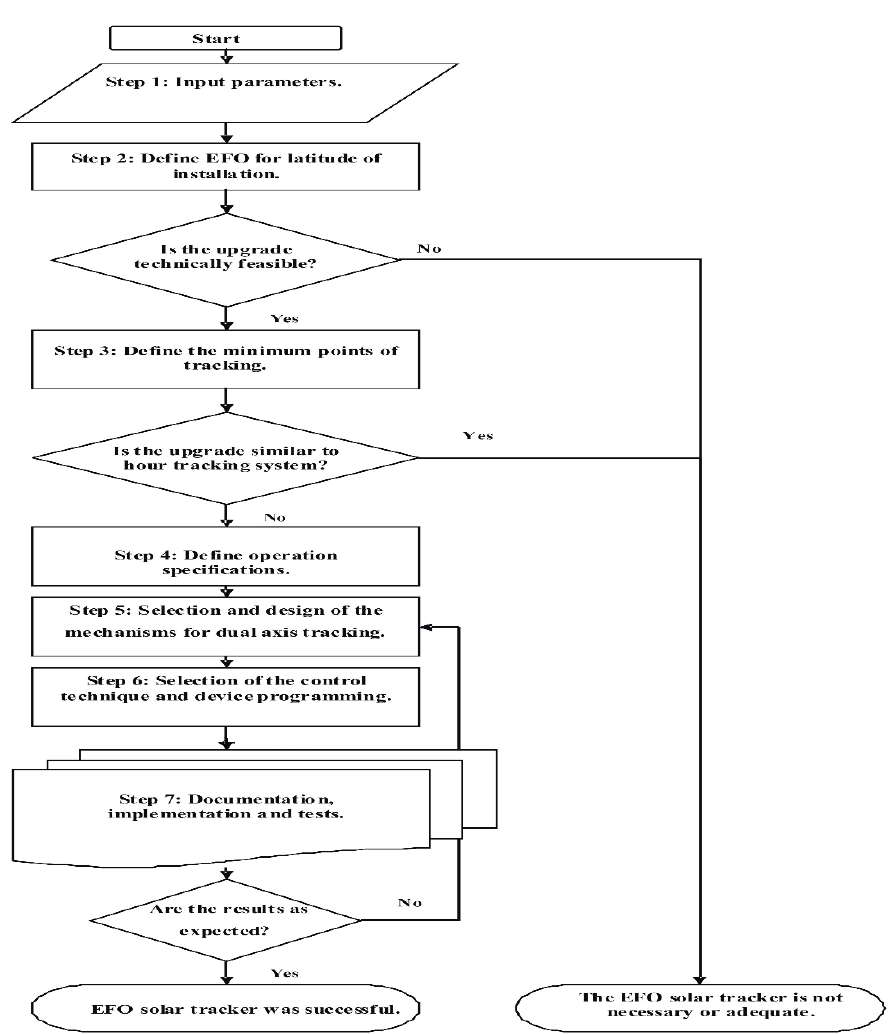
Figure 1. Efficiency as a function of orientation (EFO) solar tracker methodology.